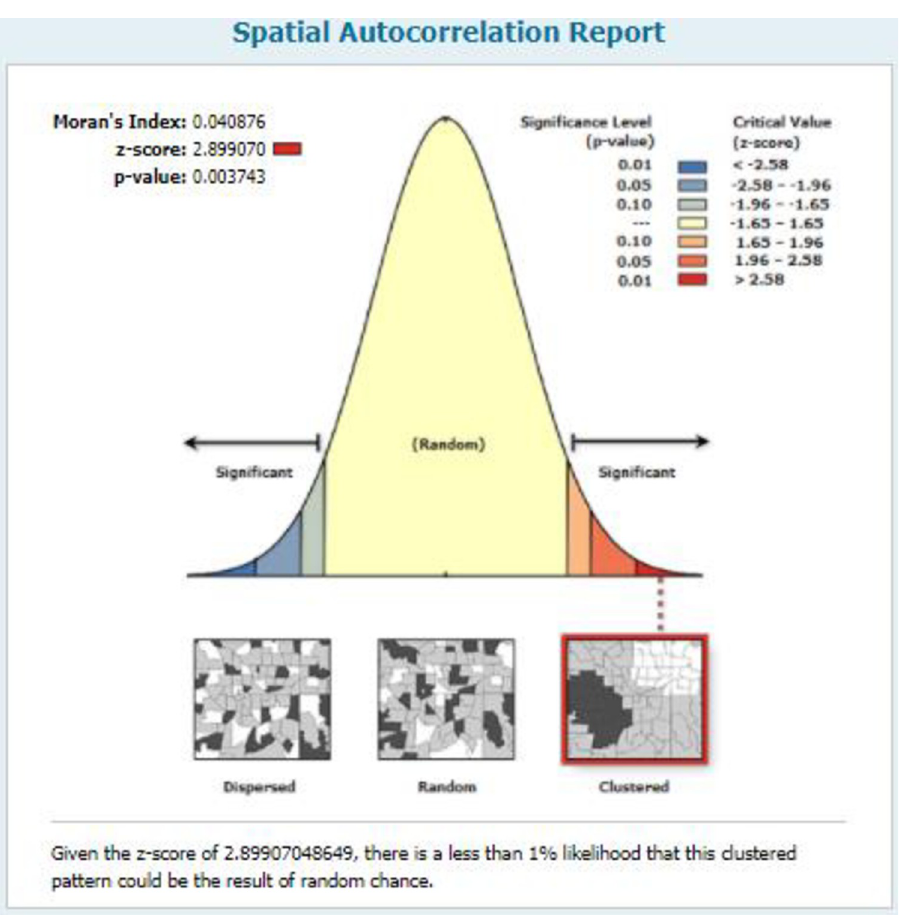
Fig 2. The spatial autocorrelation of IPV in South Africa,